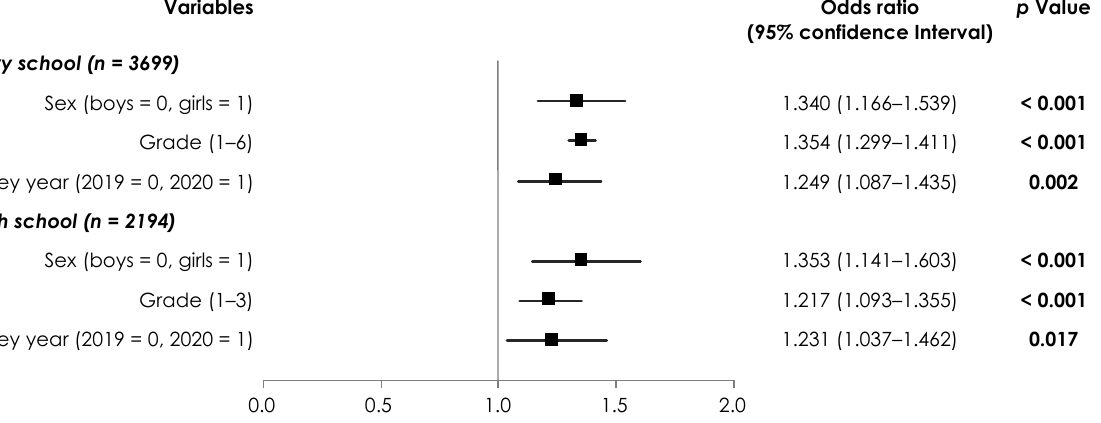
Figure 1. Binomial logistic regression analysis of the relationship between the survey year and poor eyesight. The dependent variable was eyesight score (0 = A, 1 = B–E), and the independent variable was the survey year. Measures of associations are displayed as odds ratios (black squares) and 95% confidence intervals (horizontal spikes). Significant p values are shown in bold.